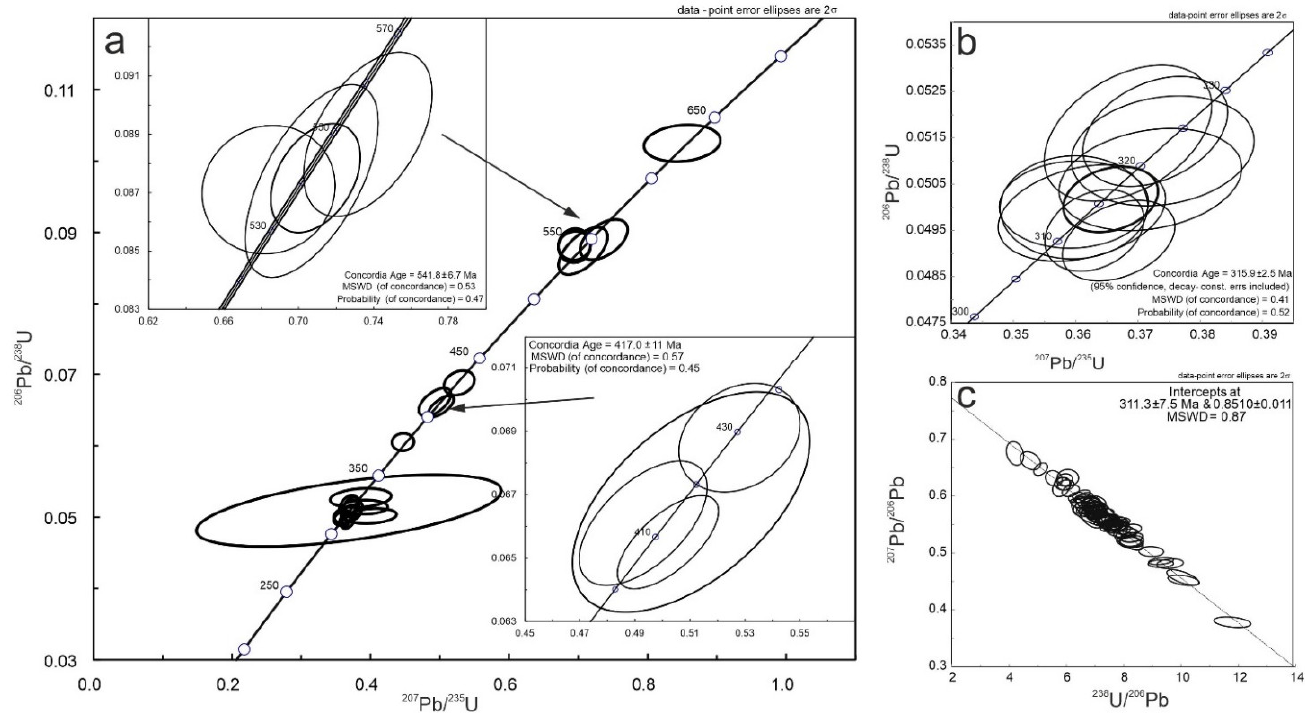
Figure 5. Concordia plots of LA-ICP-MS zircon analytical results from Osielec granite with inserts of inherited cores ( a ), concordia plot of the main magmatic age ( b ) and Tera-Wasserburg concordia plot for apatite from Osielec granite ( c ). Table 4. Chemical composition and selected petrological indices of the whole-rock samples of ex- otic crystalline blocks.